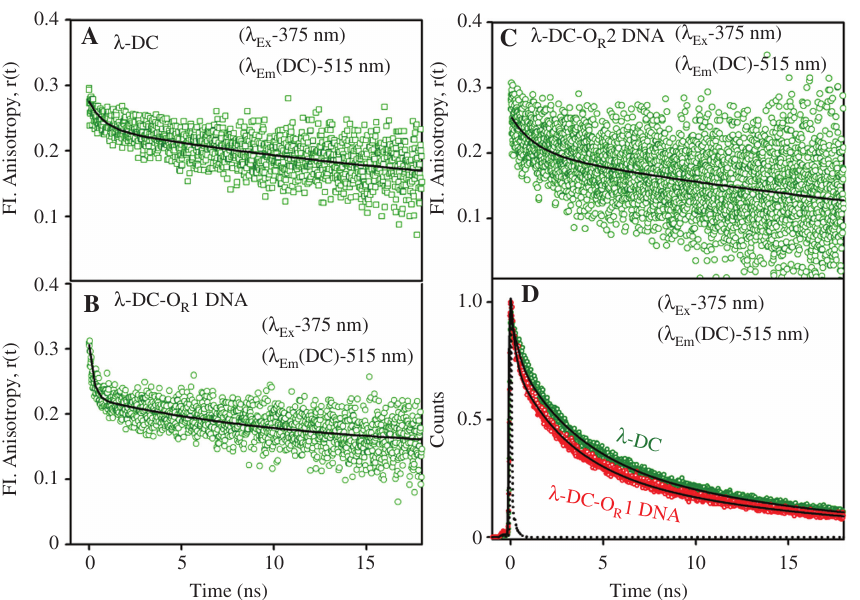
1 DNA complex ( λ -DC-O 1 DNA; R R